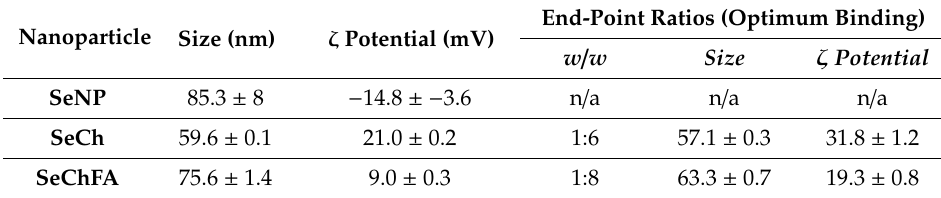
Table 1. Size and ζ potential of nanoparticles and nanocomplexes.